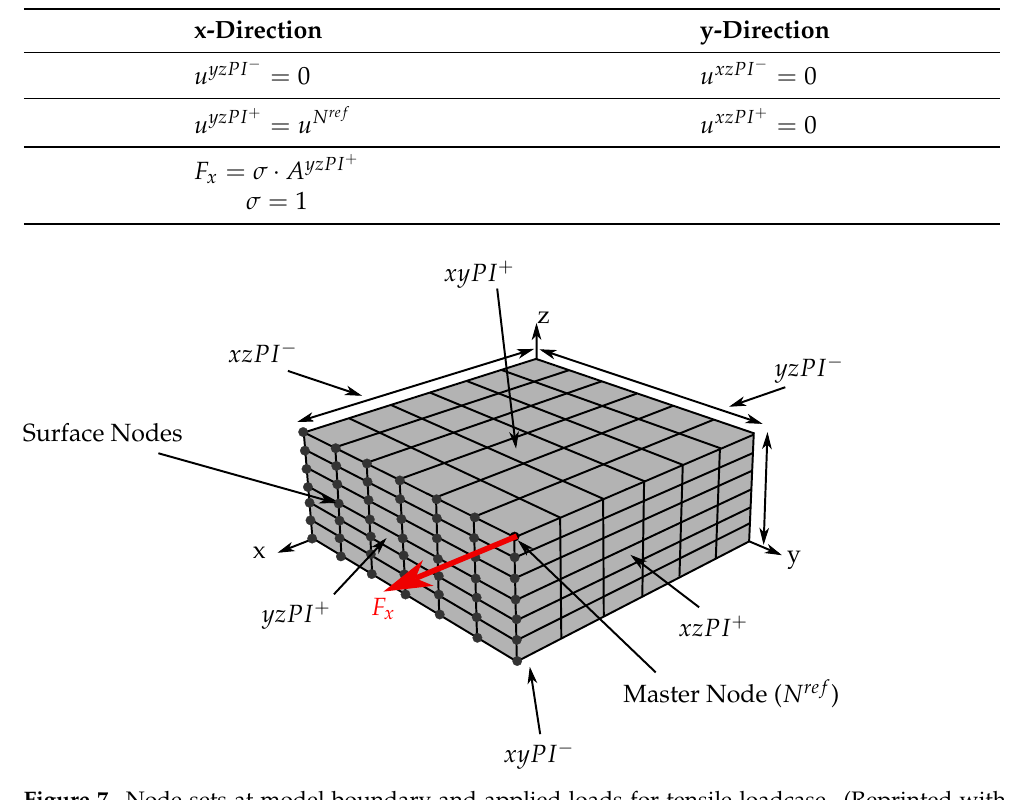
Figure 7. Node sets at model boundary and applied loads for tensile loadcase. (Reprinted with permission from Ref. [29], 2020, F.